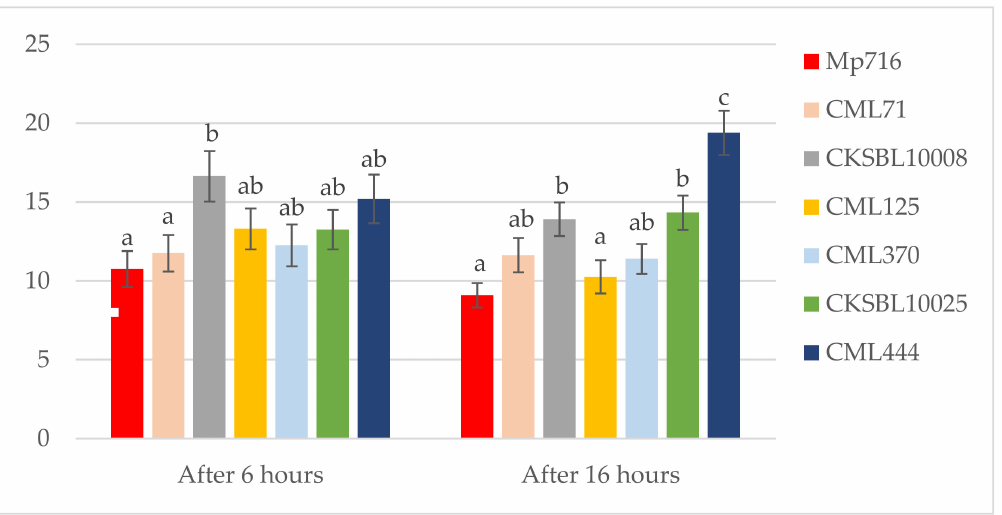
Figure 6. Mean percentage ( ± SE) of Spodoptera frugiperda neonates found on silk portions of each inbred line under multiple choice conditions after 6 (n = 80) and 16 (n = 78) hours of bioassay in a Petri dish. Means within experimental time followed by different letters are significantly different at 5% probability level according to Dunn’s Test.